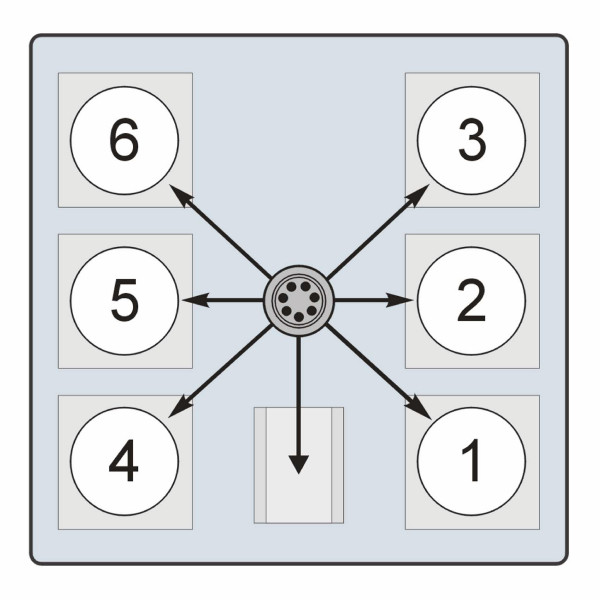
Overhead view of whole-body plethysmograph chamber configuration.